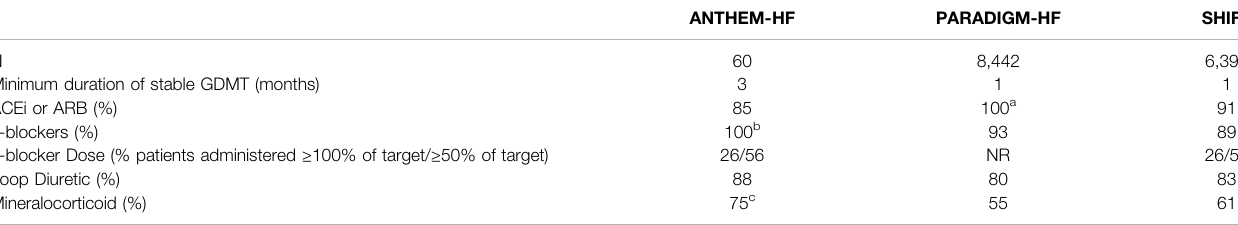
TABLE 4 | Comparison of background pharmacologic therapy administered in ANTHEM-HF, PARADIGM-HF, and SHIFT.